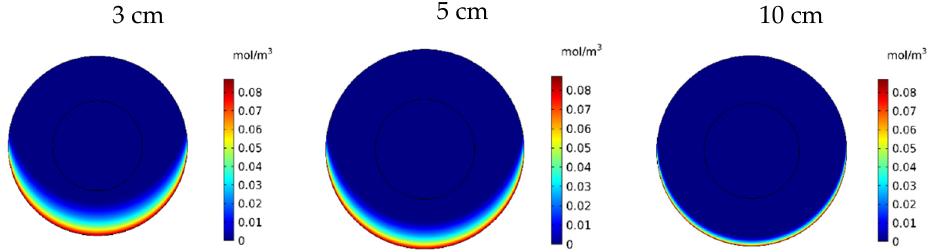
Figure 20. Free drug concentration ( C F ) contours 60 min after IP injection using drug-coated MNPs at different distances between the magnetic source and the tumor center.